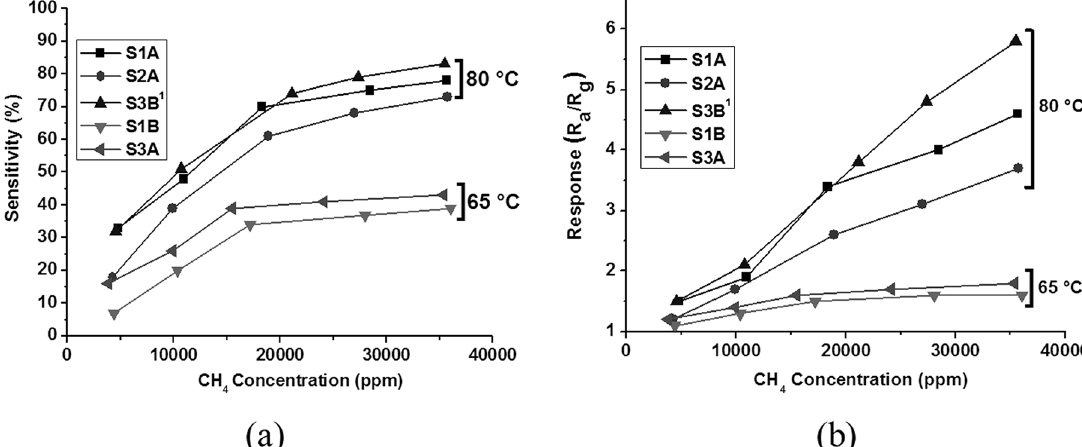
concentrations for: a) Sensitivity at 65 and 80 ºC, and b) Response at 65 and 80 ºC. Figure 7. Gas sensor properties at different CH 4 Wang et al. 15 , small particles influence the mobility of free charge carriers, with the potential to significantly improve sensitivity of metal oxide gas